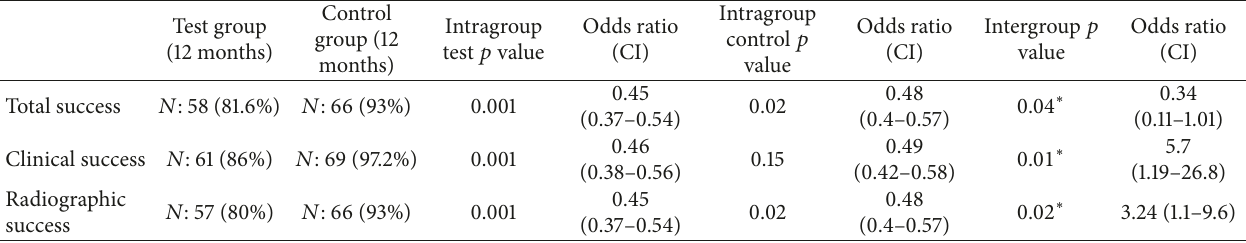
Table 1: Success of the two groups after 12